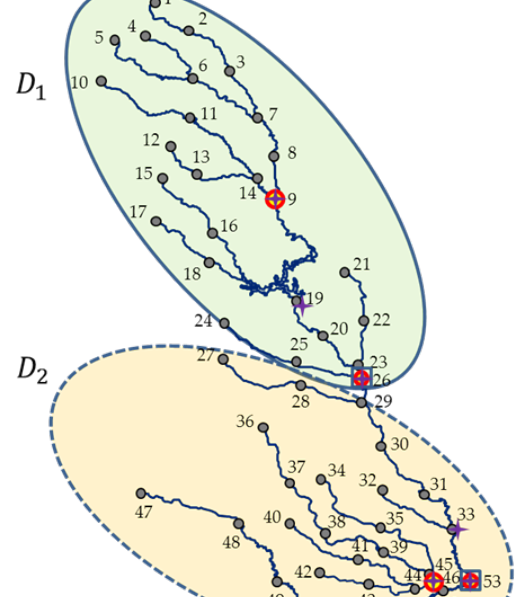
Figure 9. Unified classification model with random forest models Φ 1 ( z 1 ) and Φ 2 ( z 2 )